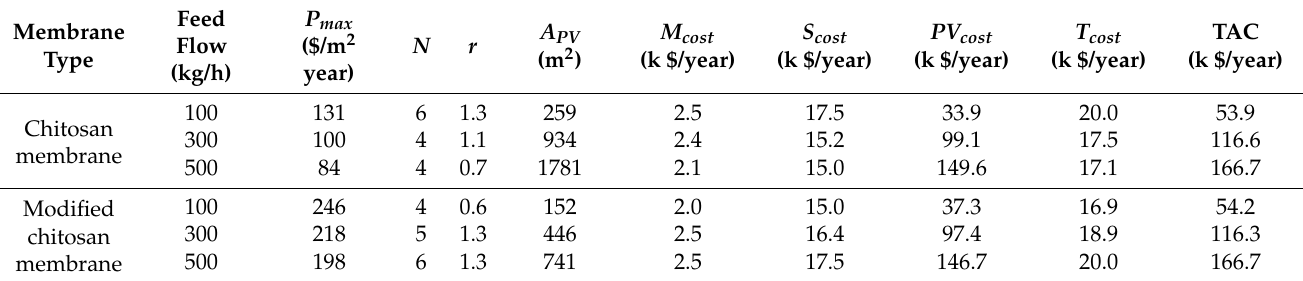
Table 2. The optimal integrated process parameters are obtained by using the modified membrane and the modified membrane under three feed flow rates, when the methanol content of the feed is 10 wt%.